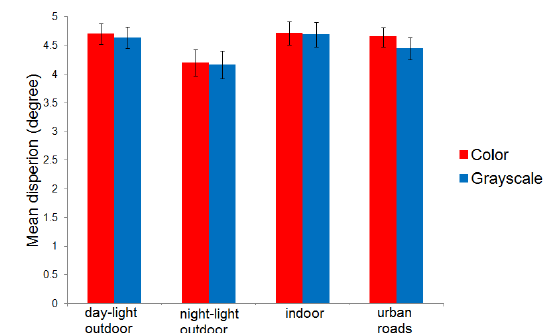
Figure 4 . Mean dispersion according to stimulus cate- gory for color stimuli (red columns) and for grayscale stimuli (blue columns). Error bars represent the standard error (standard deviation divided by the root square of the number of items).